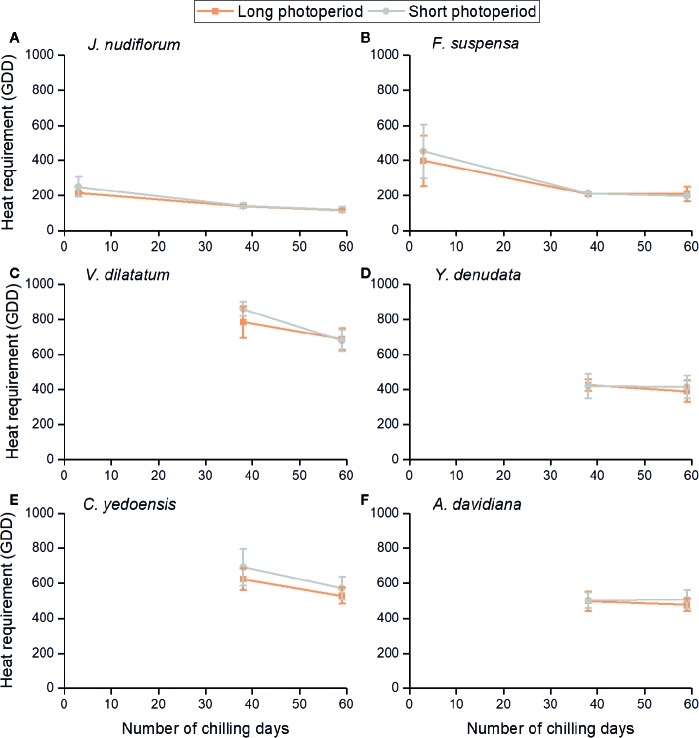
Relationships between mean heat requirement of the first flowering date (FFD) of six species and chilling accumulation under long and short photoperiod conditions. Heat requirement was calculated as the accumulated degree days (above 5°C) from the sampling date to FFD. The error bars indicate standard deviation among 3 temperature treatments × 3 replicates. (A)
J. nudiflorum, (B)
F. suspensa, (C)
V. dilatatum, (D)
Y. denudata, (E)
C. yedoensis, (F)
A. davidiana.